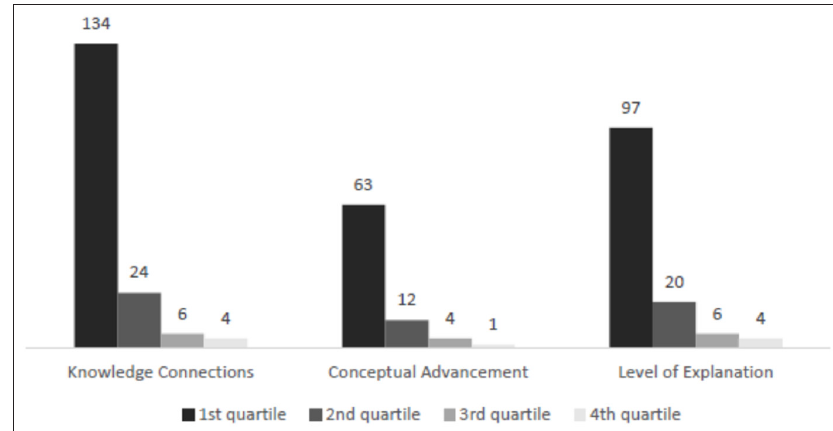
Figure 4: Number of responses by quartile and knowledge-building